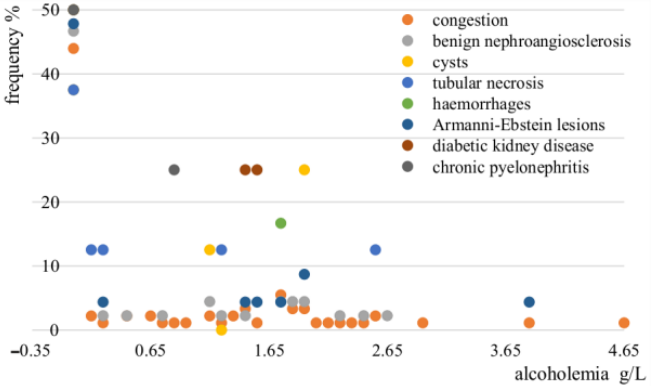
Figure 6. Frequency of cases according to kidney microscopy findings and alcoholemia in the study group.